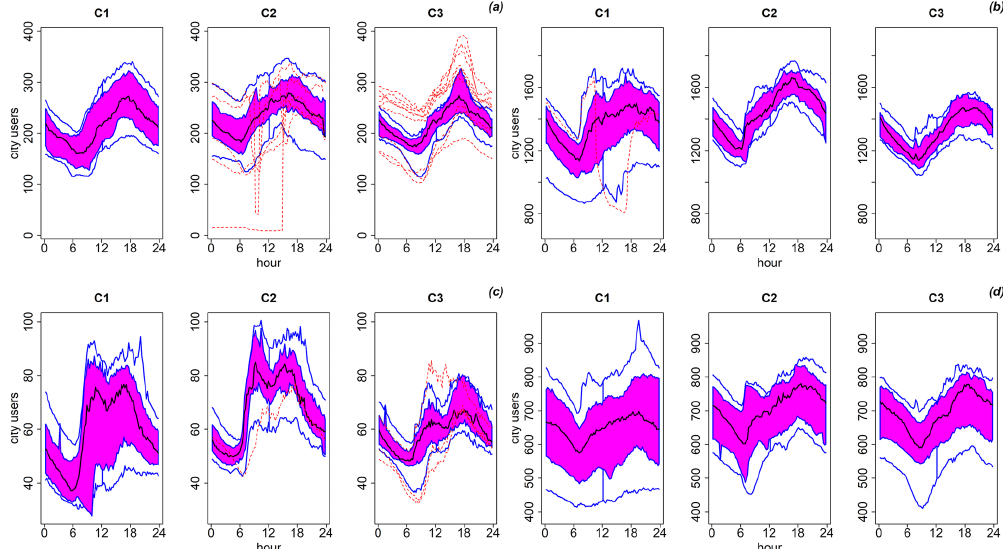
Figure 6. Functional box plots of exposed people (“city users”) inside residential areas: (a) Moie di Sotto (area 1 in Fig. 2), (b) Villaggio Badia and Fantasina (area 2 in Fig. 2), (c) southern Gandovere canal (area 3 in Fig. 2), (d) Roncadelle (area 7 in Fig. 2). Cluster 1 (July, August, September; C1), cluster 2 (working days from October to June; C2), cluster 3 (weekends from October to June;